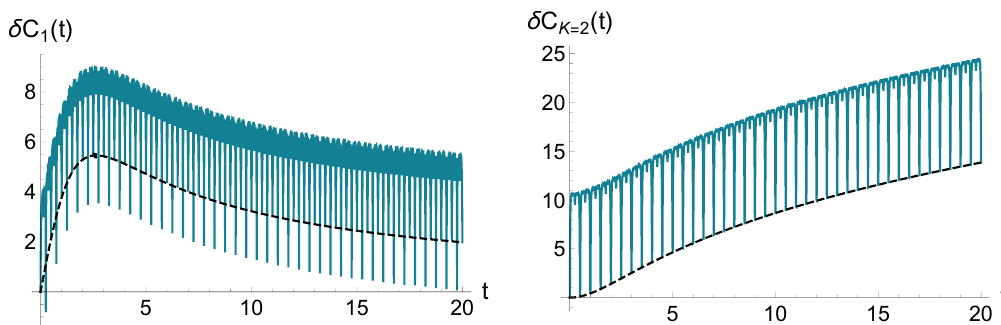
Figure 26 . δ C ( t ) evolution with undeformed Hamiltonian. F 1 (left) and F κ =2 (right) for L = 1 , N = 1200 , Ω = 0 . 6 and m = 10 − 6 , T = 10 . The dashed black curve represents the zero-mode